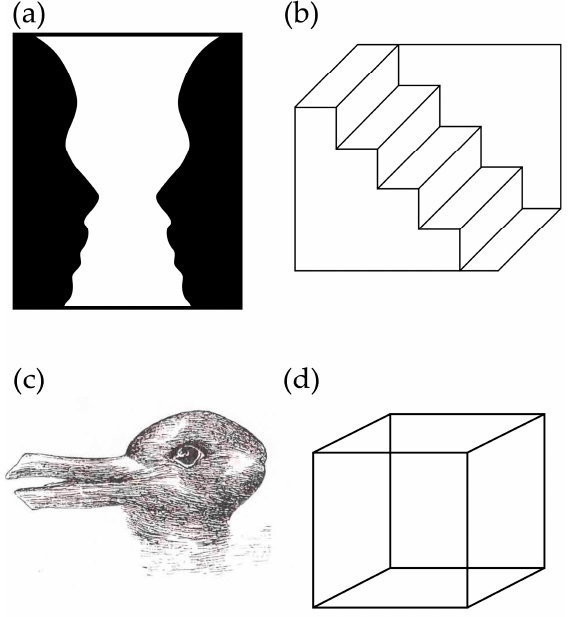
Figure 5. Examples of bistable visual percepts. ( a ) Rubin vase; ( b ) Schroeder stairs; ( c ) duck–rabbit; and ( d ) Necker cube. (Reproduced with permission from ( a ) Wikipedia, CC BY-SA 3.0; ( b ) public domain; ( c ) public domain; ( d ) Wikipedia, CC BY-SA 3.0.).